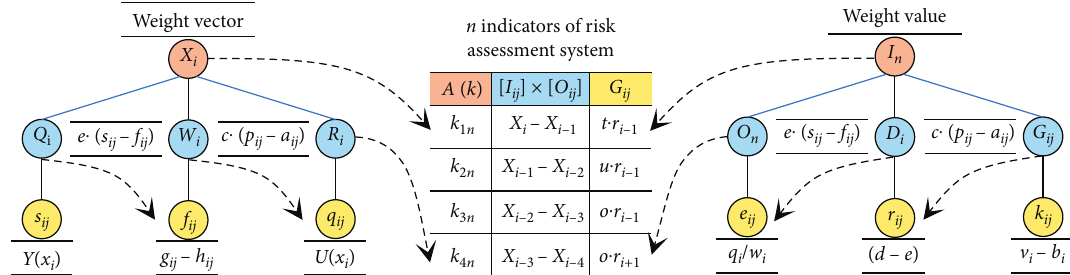
Figure 2: Assessment indicators for college student entrepreneurship based on big data